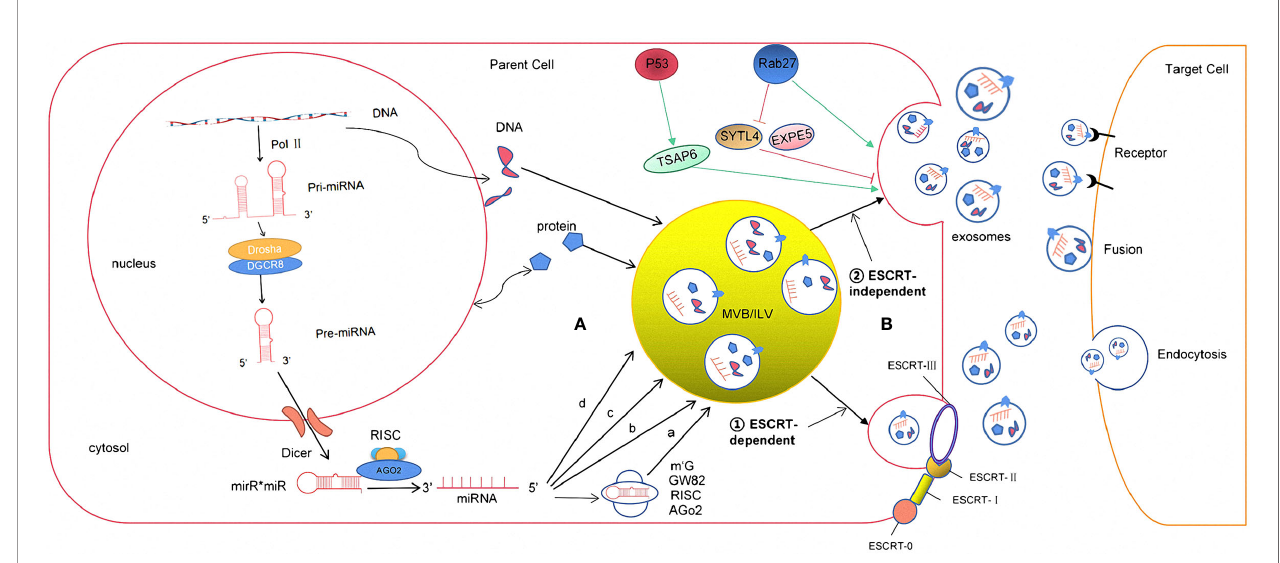
FIGURE 1 | The formation and release process of exosome miRNA were revealed. (A) The sorting mechanism of exosomal miRNA MiRNA genes are transcribed into primary miRNAs (pri-miRNA) by Pol-II. Then, with the catalytic action of DGCR8 and Drosha complex, pri-RNA are transmitted into pre-miRNA, which are exported out of the nucleus by exportin5 complex. In the cytoplasm, the pre-miRNAs are digested by the Dicer complex into double-stranded miRNAs, which turn to be single-stranded ones, mature miRNAs, in the next step by Helicase. Mature miRNAs are sorted into exosomes via four potential modes: (a) neutral sphingomyelinase 2 (nSMase2)-dependent pathway. (b) miRNAs motif and heterogeneous ribonucleoprotein (hnRNPs)-dependent pathway; (c) miRNAs sequence 3 ′ -terminal-dependent pathway; (d) Y-box binding protein-1 (YBX-1)-dependent pathway. (B) The biogenesis of exosome begins at endosome formation through endocytosis at the plasma membrane, and then, early endosomes maturate to multivesicular bodies (MVB). Exosomes are formed as intraluminal vesicles in MVBs though endosomal sorting complexes required for transport (ESCRT) dependent or independent pathway. Generally, MVBs either fuse with the lysosome for degradation or fuse with the plasma membrane, which results in exosomes secretion. After secretion, exosomes uptake by target cells is mediated by endocytosis, fusion with the plasma membrane, or ligand/receptor